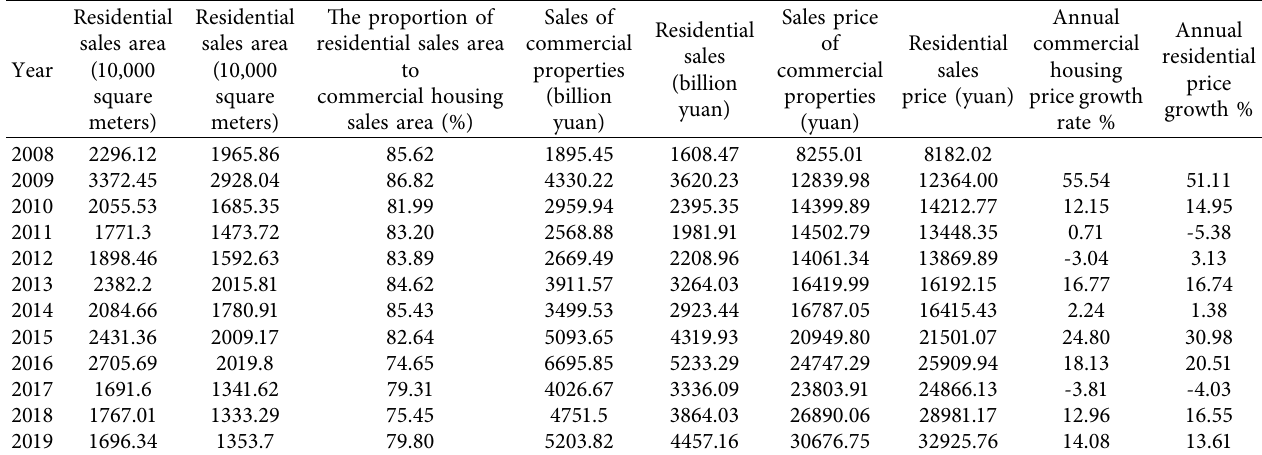
Table 10: Shanghai panel